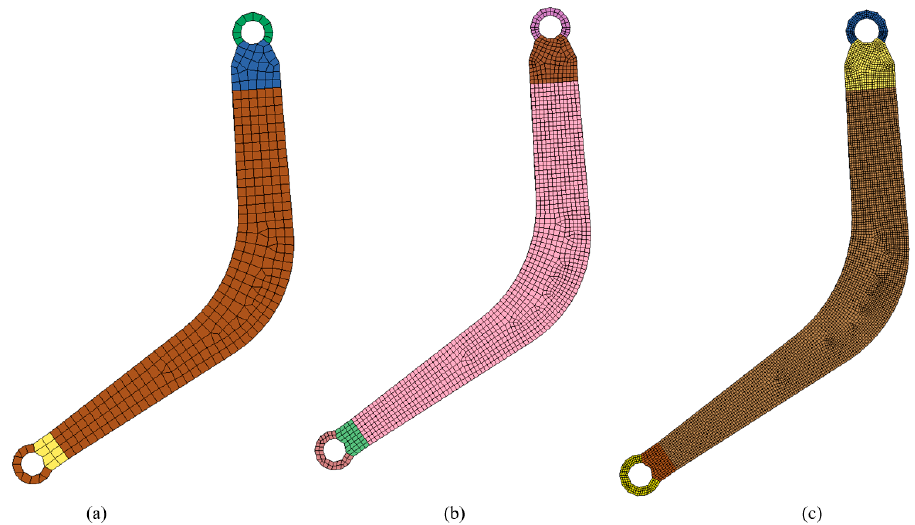
Figure 6. Meshing of the rear leg of seat models with ( a ) 692 elements, ( b ) 2768 elements and ( c ) 11,052 elements.